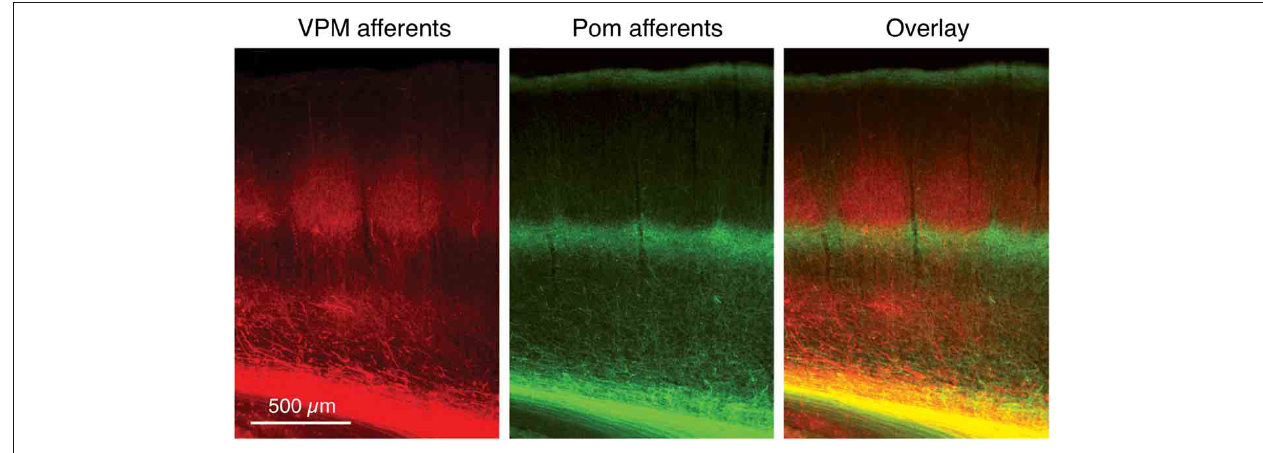
FIGURE 1 | Dual labeling of axons projecting from the VPM and POm axons. Labeling of VPM and POm axons in the same animal by adeno-associated virus-mediated expression of different fluorescent proteins. VPM afferents (red) in a thalamocortical barrel cortex slice. POm afferents (green). Overlay of VPM and POm labeled thalamocortical axons